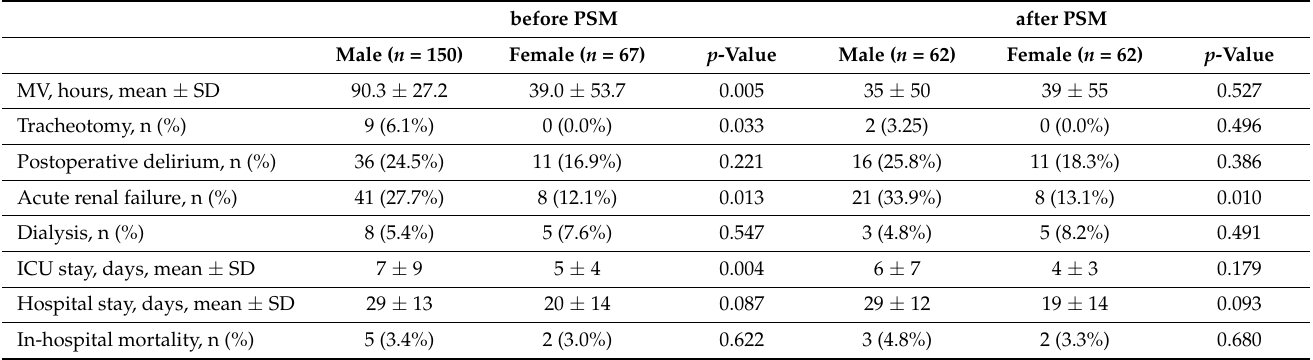
Figure 4. Distribution of pathogens in female patients with DSWI. Table 4. Postoperative